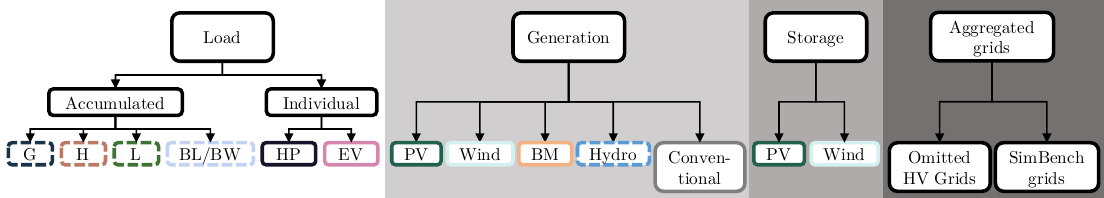
Figure 1. Overview of the SimBench time series